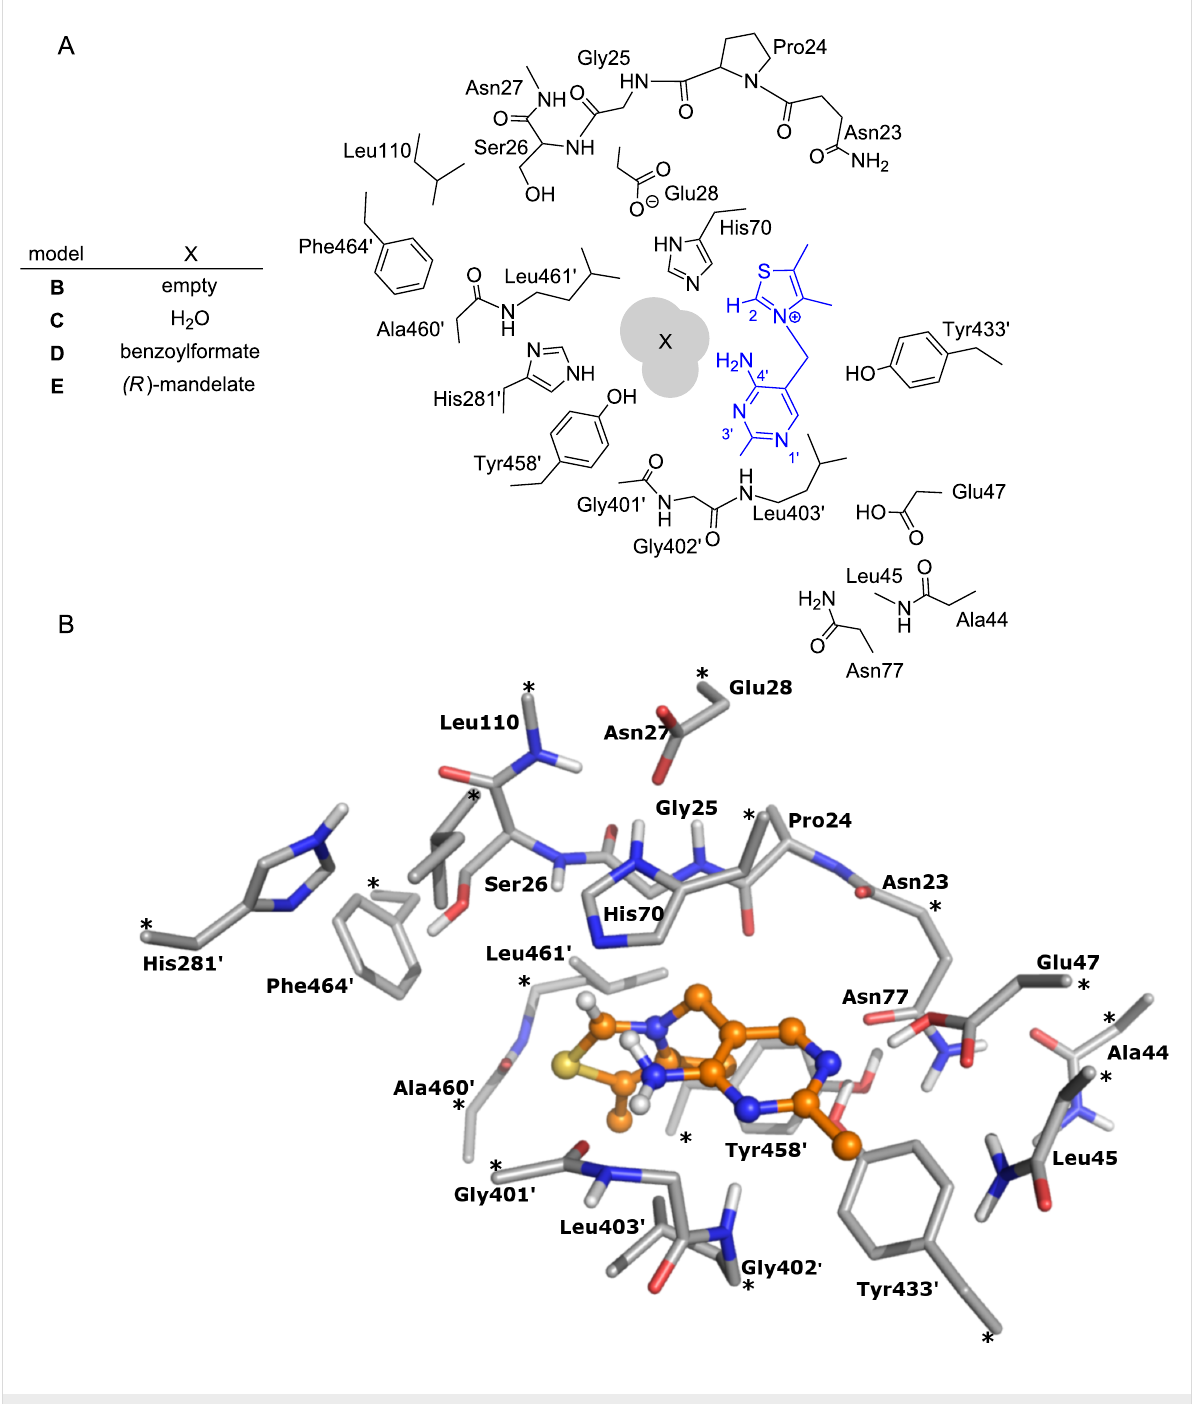
Figure 1: A) 2D representation of ThDP (blue) and the residues included in the active site models, and B) optimized structure of model B with an empty active site. Asterisks mark atoms that were kept fixed to their crystallographic positions during the geometry optimization. The BFDC active site has contributions from two monomers and primes re-used to indicate residues from the second monomer. For clarity, the non-polar hydrogens of the residues are not included.